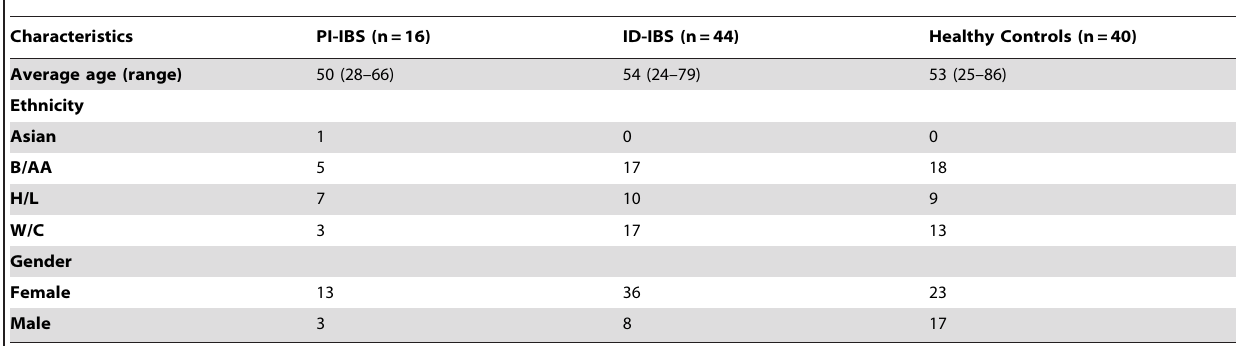
Table 1. The characteristics of the study population.